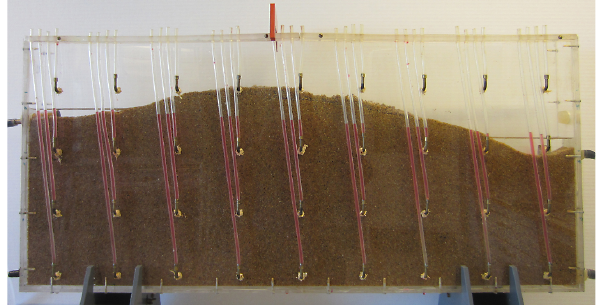
Fig. 4. Tank for two-dimensional groundwater flow. The water in the piezometric tubes is coloured in order to make the water levels visible for the class. A close look at the figure reveals that the total head decreases with depth below the recharge lake on the left-hand side of the tank, whereas the total head increases with depth below the discharge lake on the right-hand side. In the centre of the tank, there is no vertical difference and the total head equals the ground- water